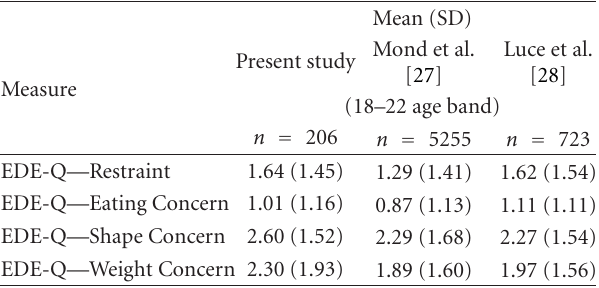
Table 2: Eating Disorder Examination Questionnaire (EDE-Q) subscale scores.